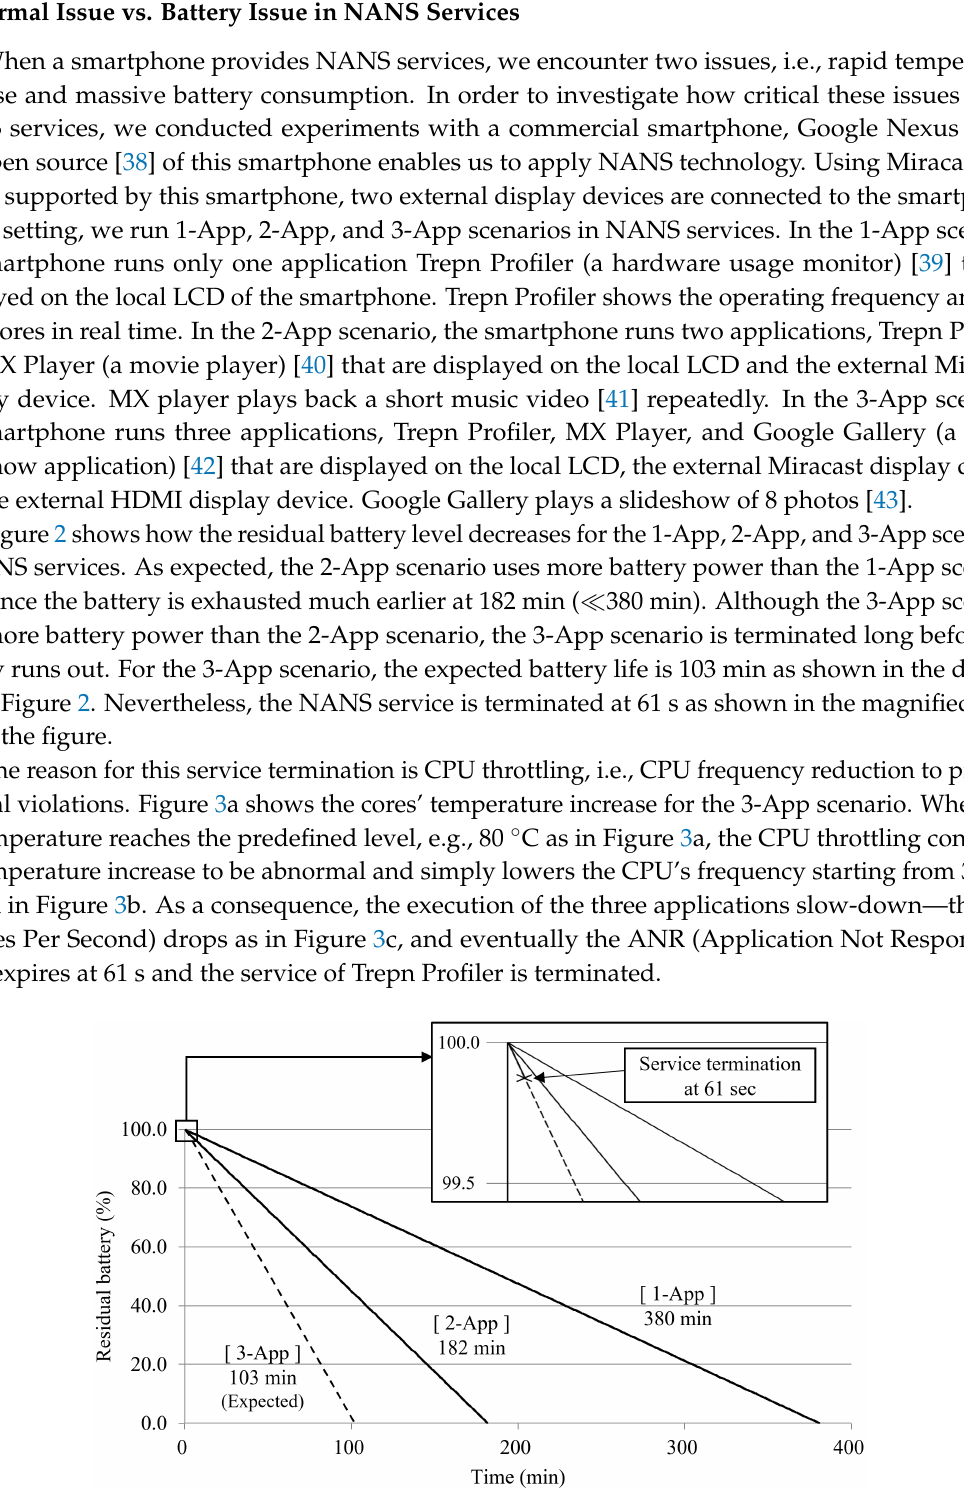
Figure 2. Battery lifetime in NANS (N-App N-Screen)